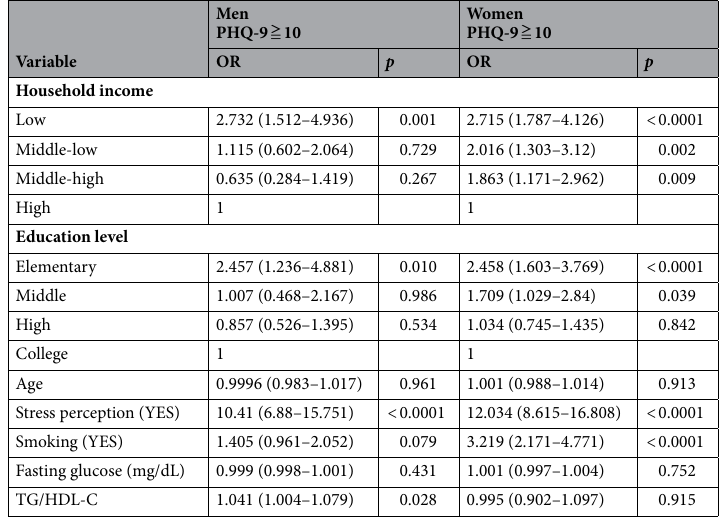
Table 3. Relationship between lipid ratio and depression. Adjusted for age, sex, education, alcohol, smoking. The ORs and 95% CI are determined through the complex sample logistic regression test. PHQ-9 Patient Health Questionnaire-9, HDL-C high density lipoprotein cholesterol, TG